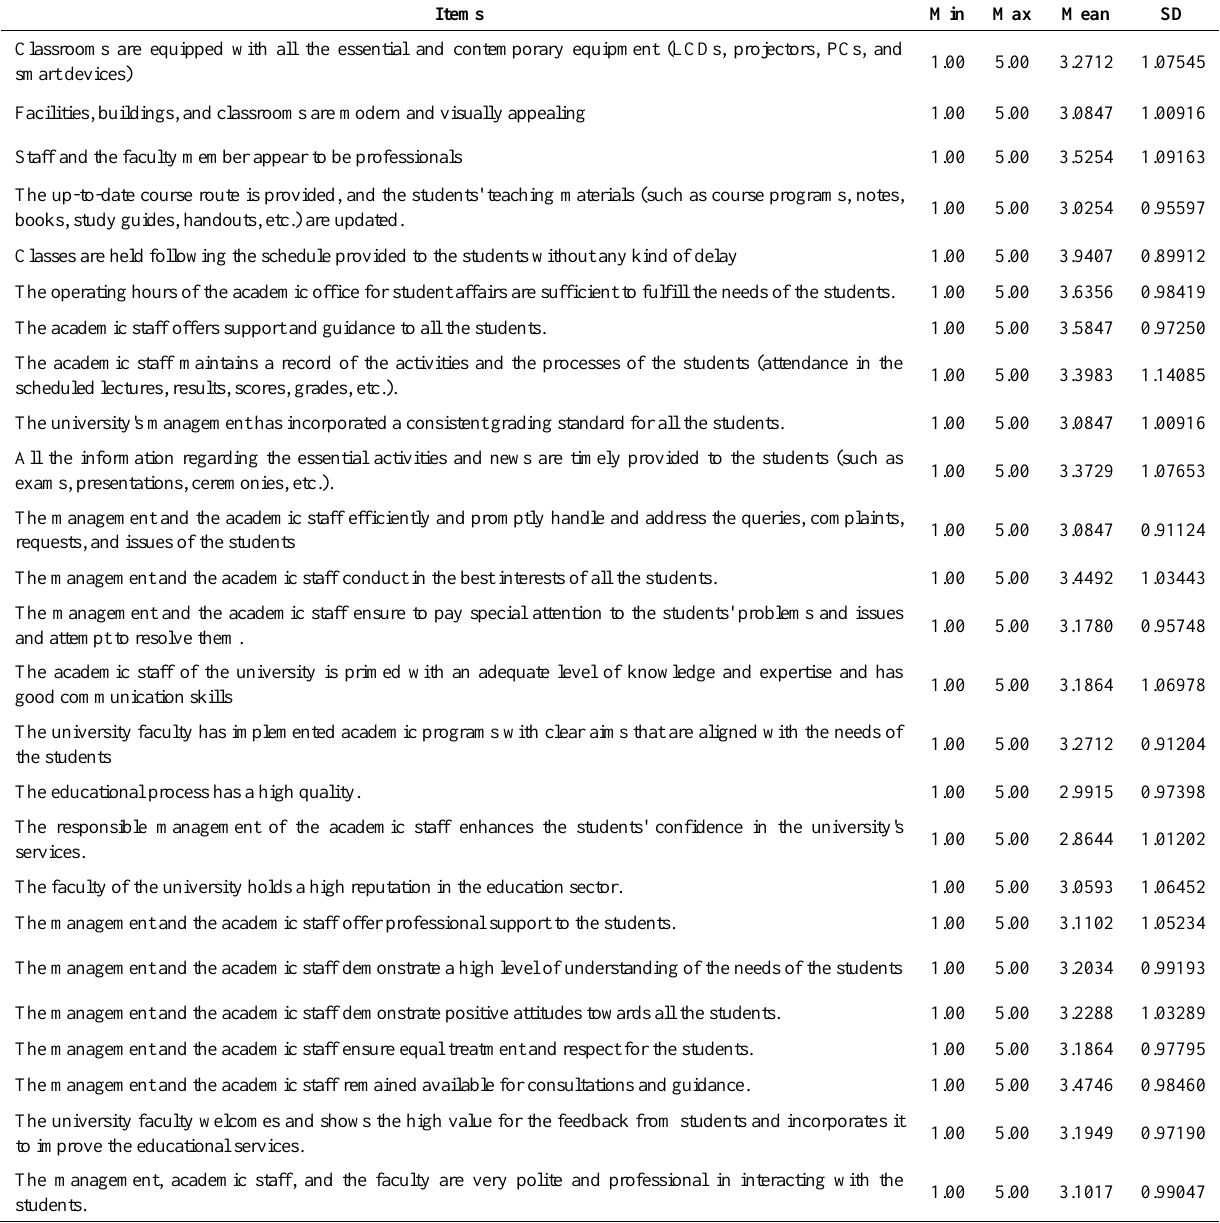
Table 5. Descriptive statistics for service quality perceptions of the students in Indonesia Items Min Max Mean